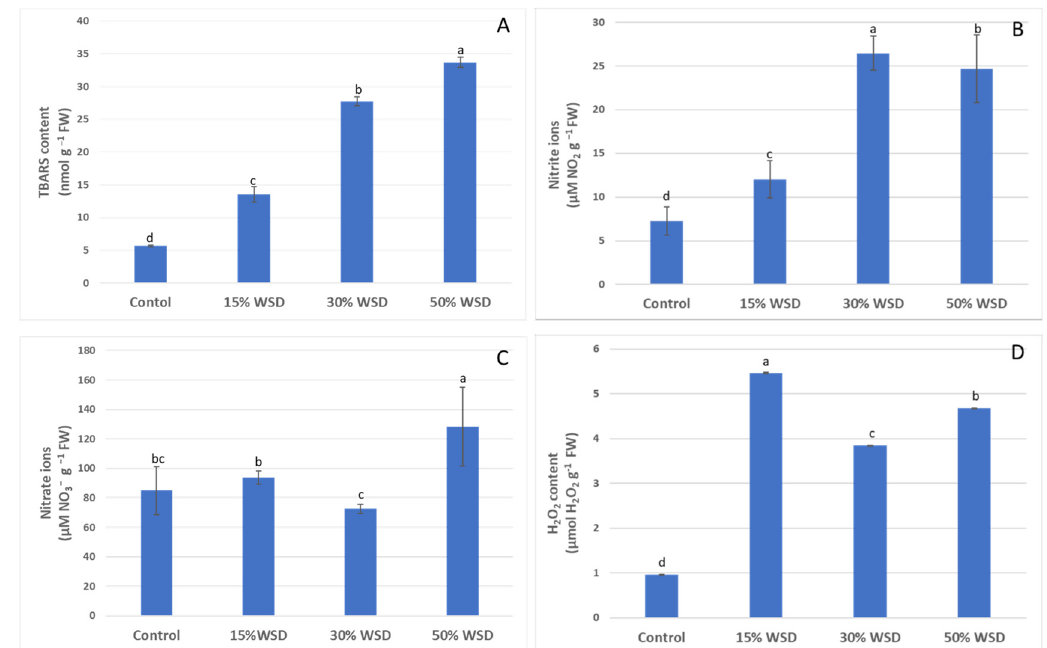
Figure 2. Lipid peroxidation as the 2-thiobarbituric acid reactive substances (TBARS) ( A ), the nitrite ions (NO 2 − ) ( B ), nitrate ions (NO 3 − ) ( C ) and the hydrogen peroxide (H 2 O 2 ) ( D ) contents in the control and dehydrated to 15%, 30%, and 50% WSD plants. Vertical bars indicate means ( n = 9) ± standard deviation. Letters indicate Fisher’s least significant differences, which were estimated at a significance level of α = 0.05.